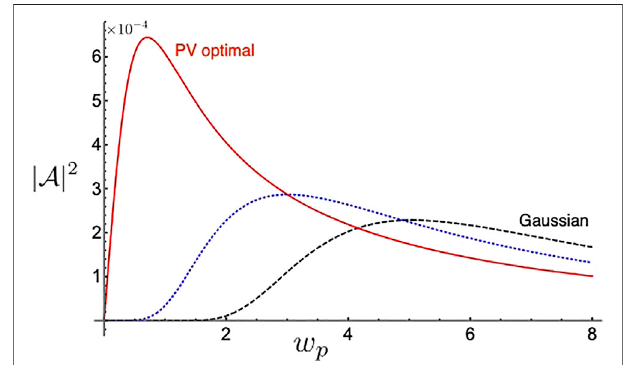
FIGURE3| Overlap squared | A | 2 asafunction ofthe pump beam width w p (inarbitraryunitsoflength)foragaussianpumpbeam r rp (cid:1) 0(blackdashed curve),andforaPVpumpbeamwithringradius r rp (cid:1) 2 w 0 ≈ 0.57 r r (bluedotted curve) and ring radius r rp (cid:1) r r (cid:1) 3.53 w 0 (PV optimal, red solid curve) for best coupling into a commercially available RCF [25]. The optimal PV pump beam increases the probability to produce relevant down-converted modes by a factor of ∼